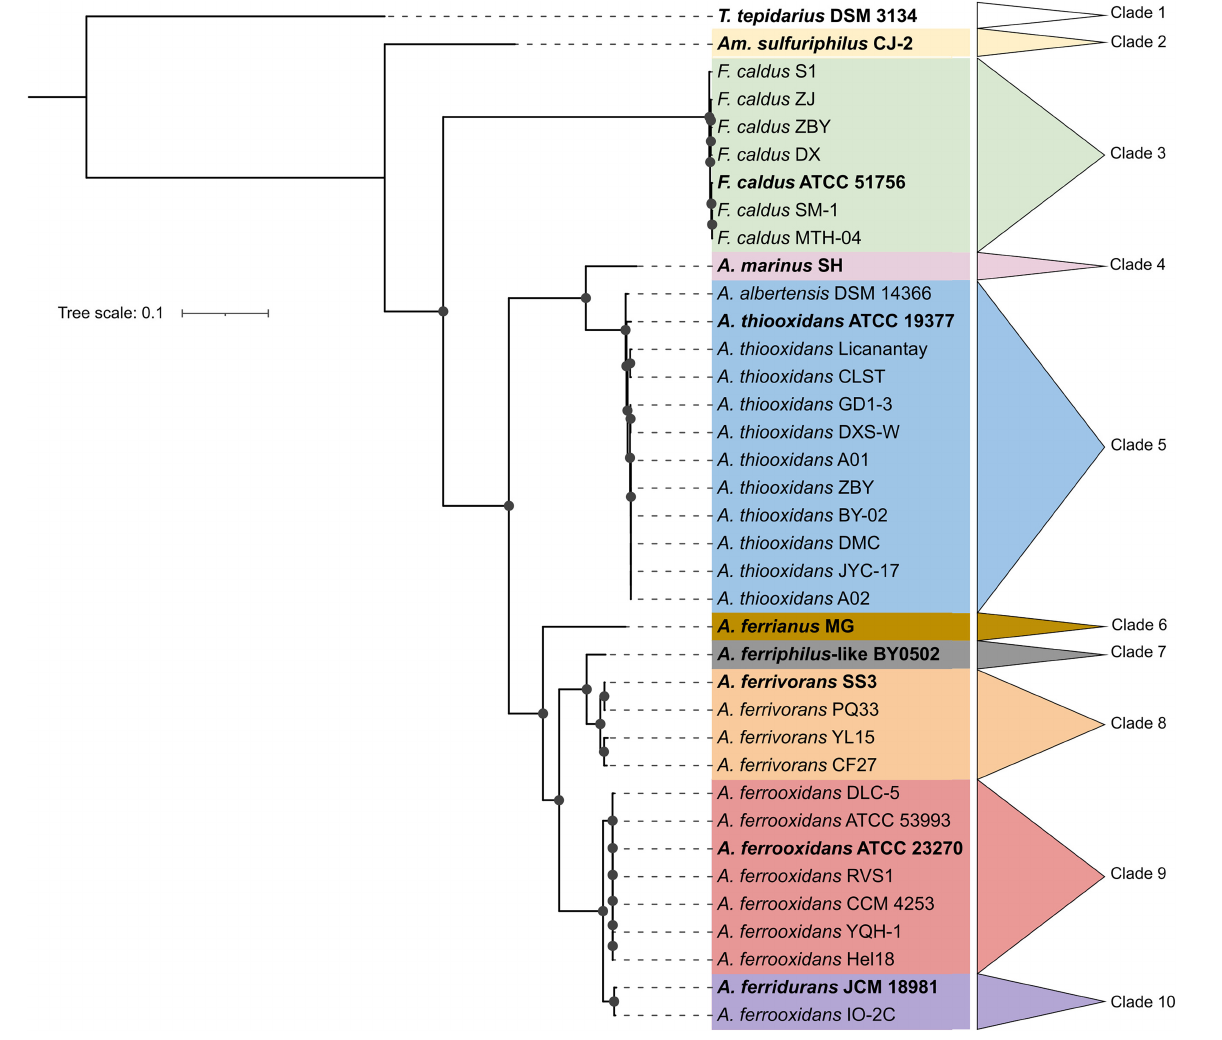
FIGURE 1 | Maximum likelihood phylogenetic tree showing the neutrophilic ancestral origins of the Acidithiobacillia class. The bold genomes were selected to represent the ten clades from Acidithiobacillia class core tree, including T. tepidarius DSM 3134 for the neutrophilic Thermithiobacillus genus and nine genomes for the acidophilic genera Ambacidithiobacillus ( Am .), Fervidacidithiobacillus ( F .), and Acidithiobacillus ( A .). The tree was constructed using 440 conserved proteins using 1,000 replicates. Bootstraps values ≥ 60% are represented by black dots on the nodes. The scale bar represents 0.1 amino acid substitution per